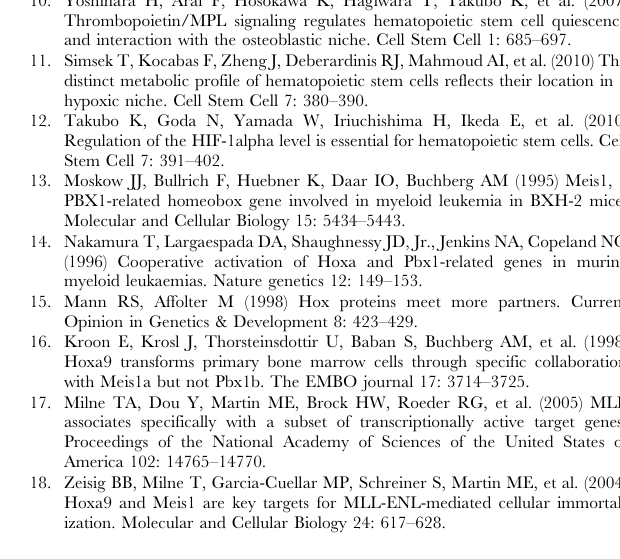
Figure S5 Loss of Meis1 severely impairs T cell development in the thymus. ( A ) Representative flow cyto- metric profiles of T cell progenitor populations in the thymus from Mx1-Cre + Meis1 fl/fl and control Meis1 fl/fl mice three weeks after poly(I:C) treatment. Numbers in each quadrant indicate percent- age of gated cells in total thymocytes. ( B ) Absolute numbers of